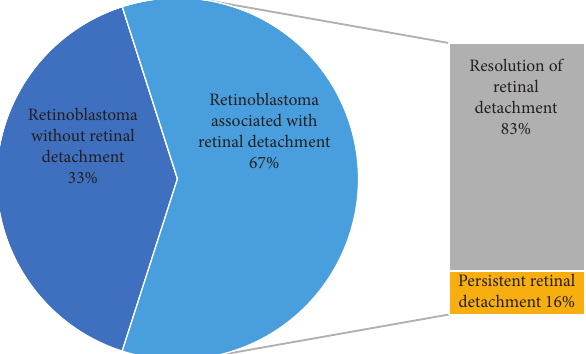
Figure 1: Pie chart illustrating the distribution of retinal de- tachment during retinoblastoma and its